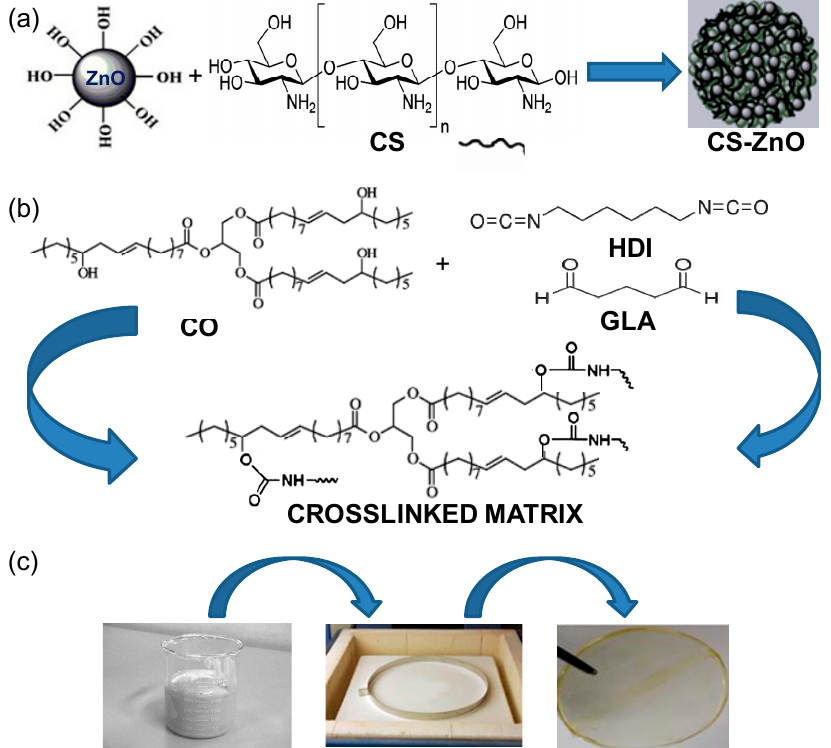
Scheme 3. Representation of the synthesis of CO/CS-ZnO NPs nanocomposites. ( a ) CS-ZnO NPs; ( b )